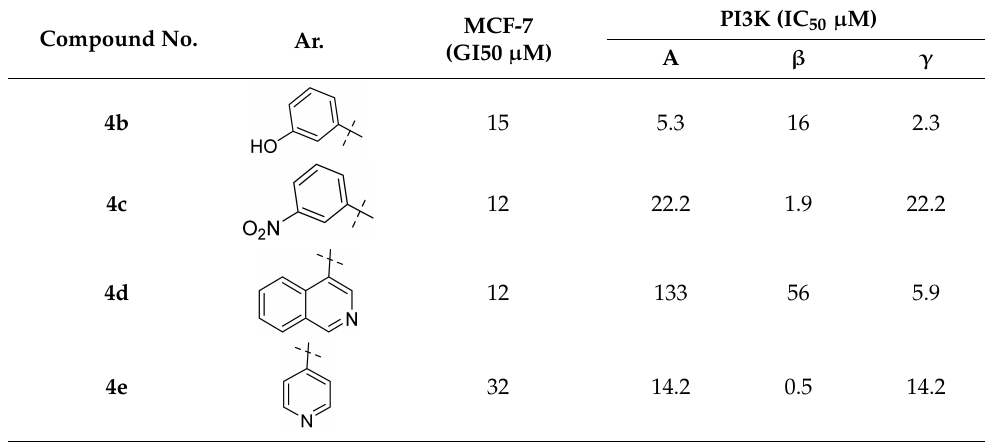
Figure 5. Structure of quinazoline ‐ based aryl hybrids and the most promising compound 4a. Table 4. In vitro cytotoxic activities of hybrid compounds 4 ( b – e ). Table 4. In vitro cytotoxic activities of hybrid compounds 4 ( b – e ). Compound No.